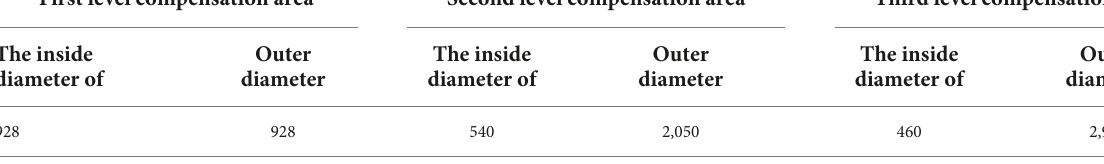
TABLE 17 Compensation area division in the SW